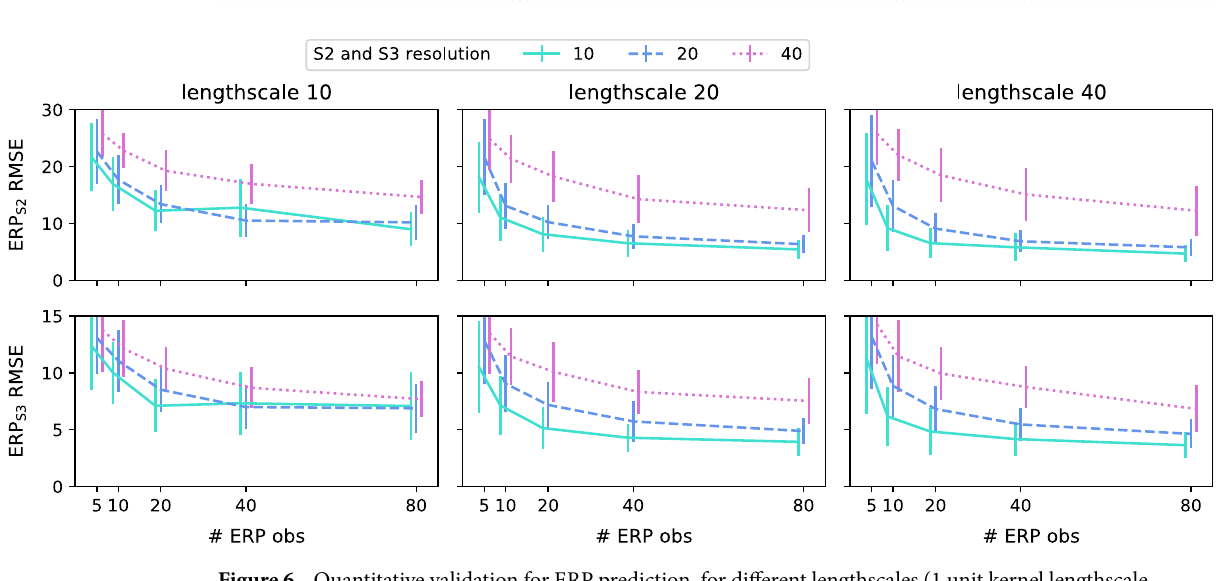
Figure 5. Ground truth and predicted APD values from simulation. All units are milliseconds.